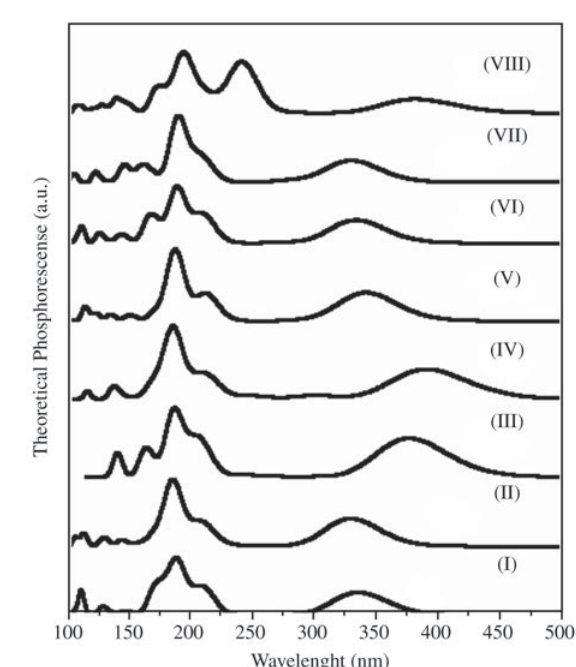
Figure 4 . Theoretical UV-vis spectra of molecules I to VIII (Ta- ble 1) calculated for optimized geometries by DNdM-INDO/S-CI (fluorescence spectra) by PM3/CI method.